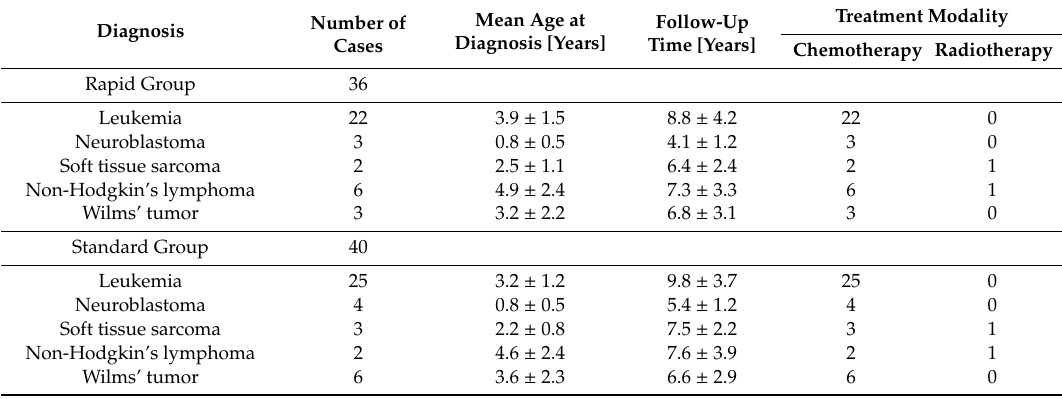
Table 2. General characteristics of both rapid and standard groups with reference to the diagnosed type of cancer, including mean age at diagnosis, follow-up time, and treatment